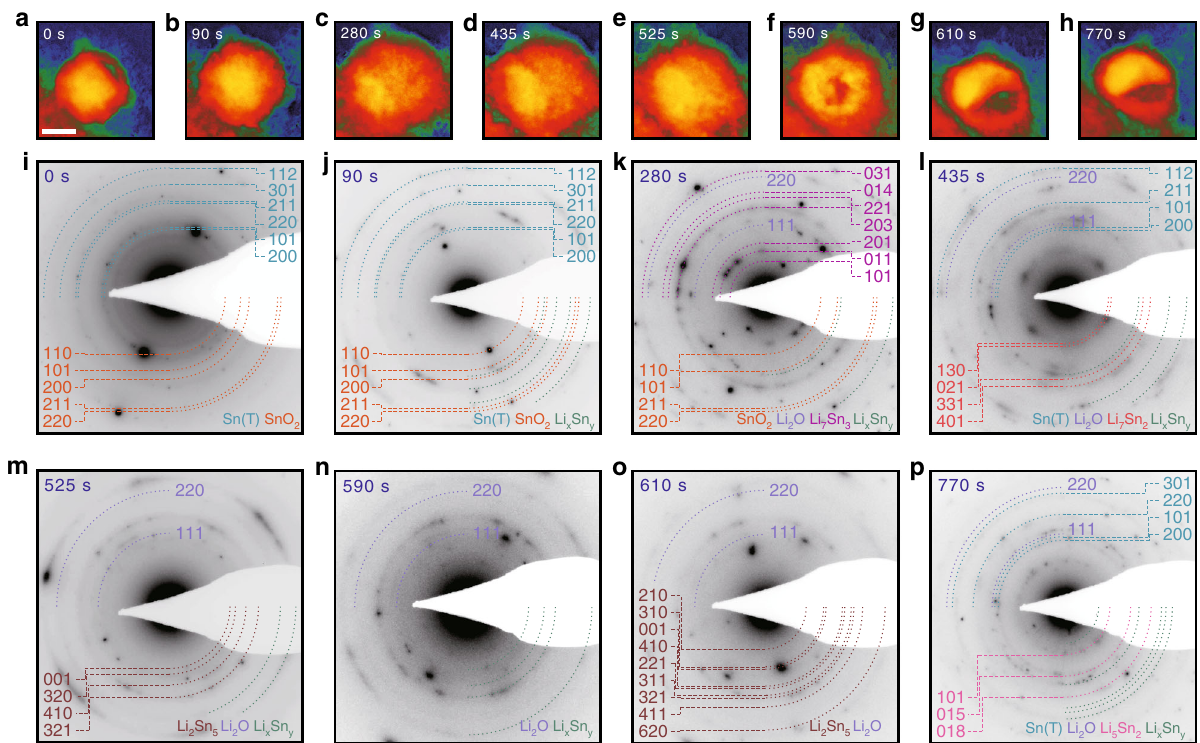
Fig. 1 Lithium (Li)-de fi cient phases nucleated during lithiation under stress. a – h Lithiation-induced volume changes during in situ lithiation of a Sn-SnO 2 core-shell particle. i – p The electron diffraction patterns taken at the respective ( a – h ) moments. The still snapshots are captured from Supplementary Movie 1. The scale bar indicates 100